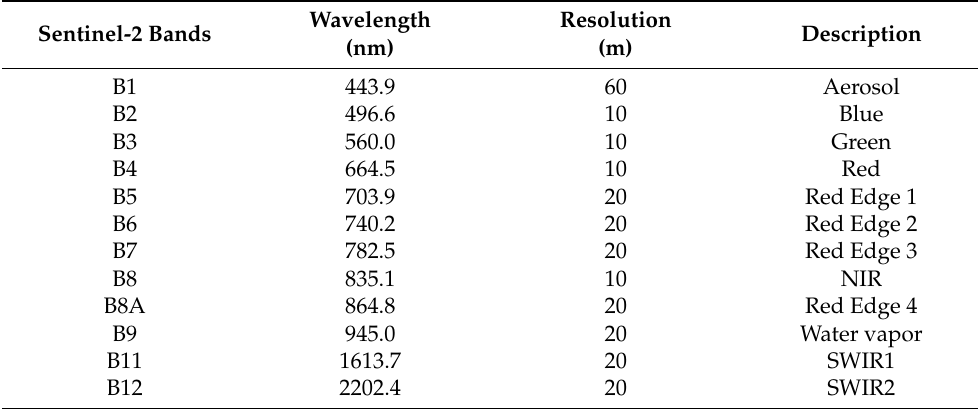
Table 1. Characteristics of the Sentinel-2 satellite.